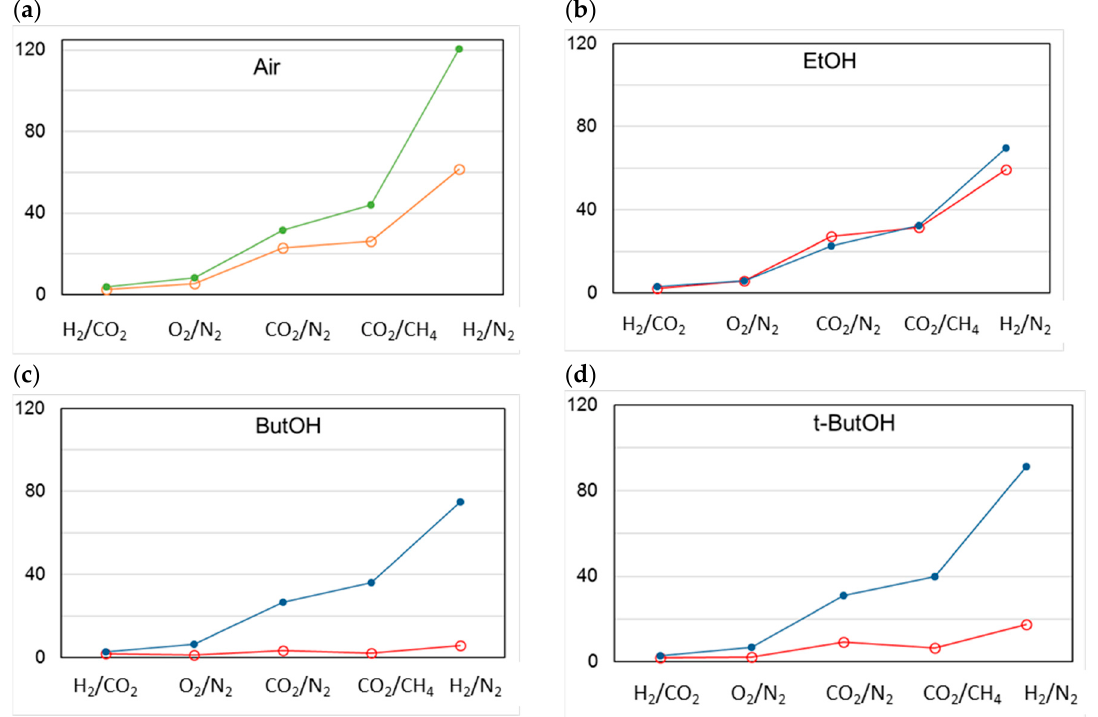
Figure 12. Change in permselectivity for different gas pairs in C1 membranes post-treated according to different protocols. Open circles: “as prepared” HFs; closed circles: aged HFs.